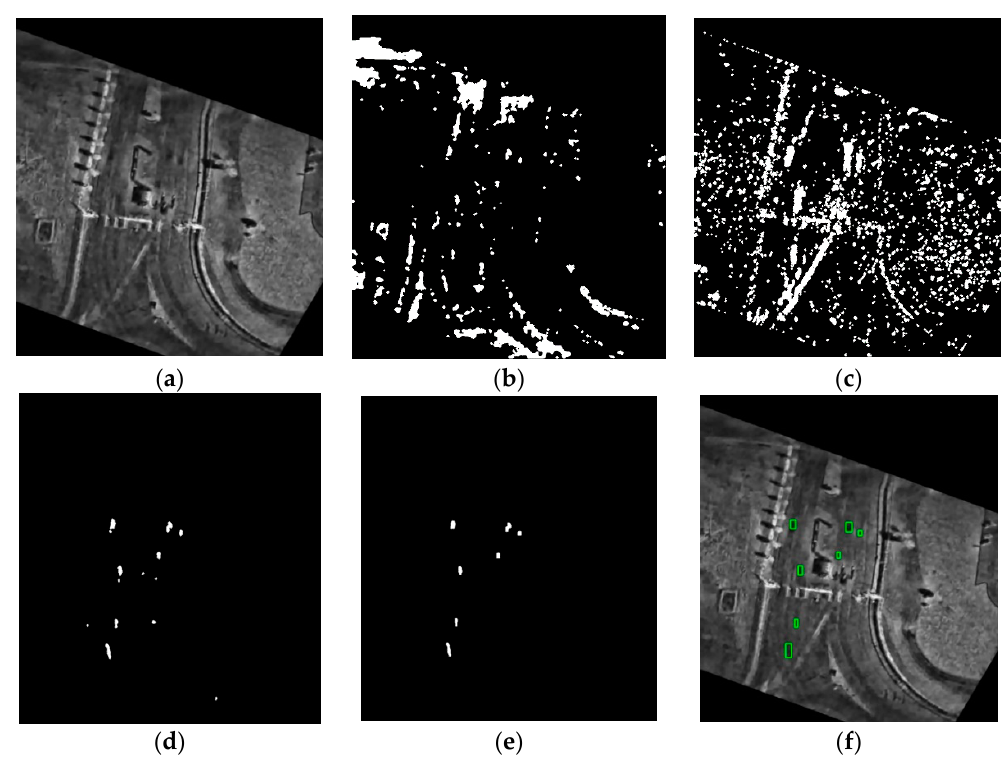
Figure 6. The results of processing of the 23rd frame. The green rectangles highlight the detected moving targets. ( a ) Results of preprocessing. ( b ) Results of background frame detection. ( c ) Results of multi-interval frame difference. ( d ) Results of fusion. ( e ) Results of false alarm suppression. ( f ) Final MTD results.